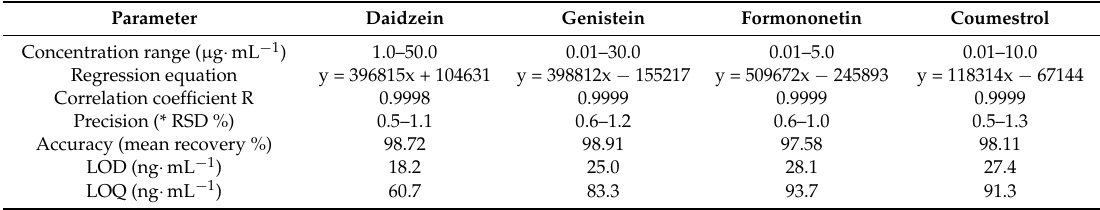
Table 1. Validation parameters ( n =